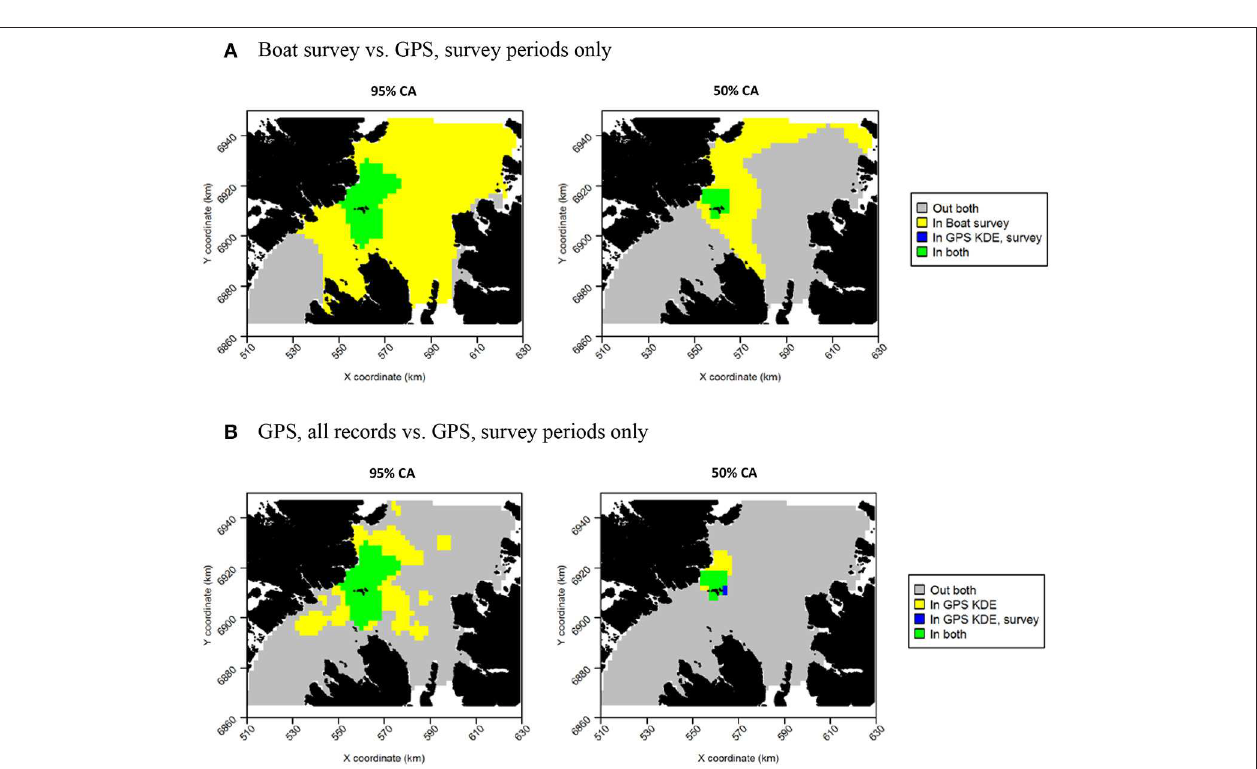
FIGURE 12 | Overlap between guillemot core areas (CAs) derived from boat surveys, GPS tracking during boat survey periods only and all GPS tracking data. In all maps, gray indicates areas outside of the CA in both data sources, and green indicates areas inside the CA in both data sources; blue and yellow indicate areas in the CA in one data source but not the other. (A) Boat survey vs. GPS, survey periods only. (B) GPS, all records vs. GPS, survey periods